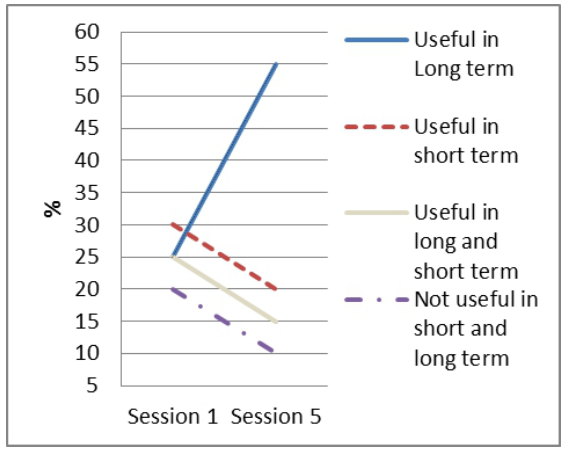
Figure 17. Usefulness of ‘suggestions feature’ in AIBO mode. The above rat- ings are based on the questionnaire results from session 1 and 5.